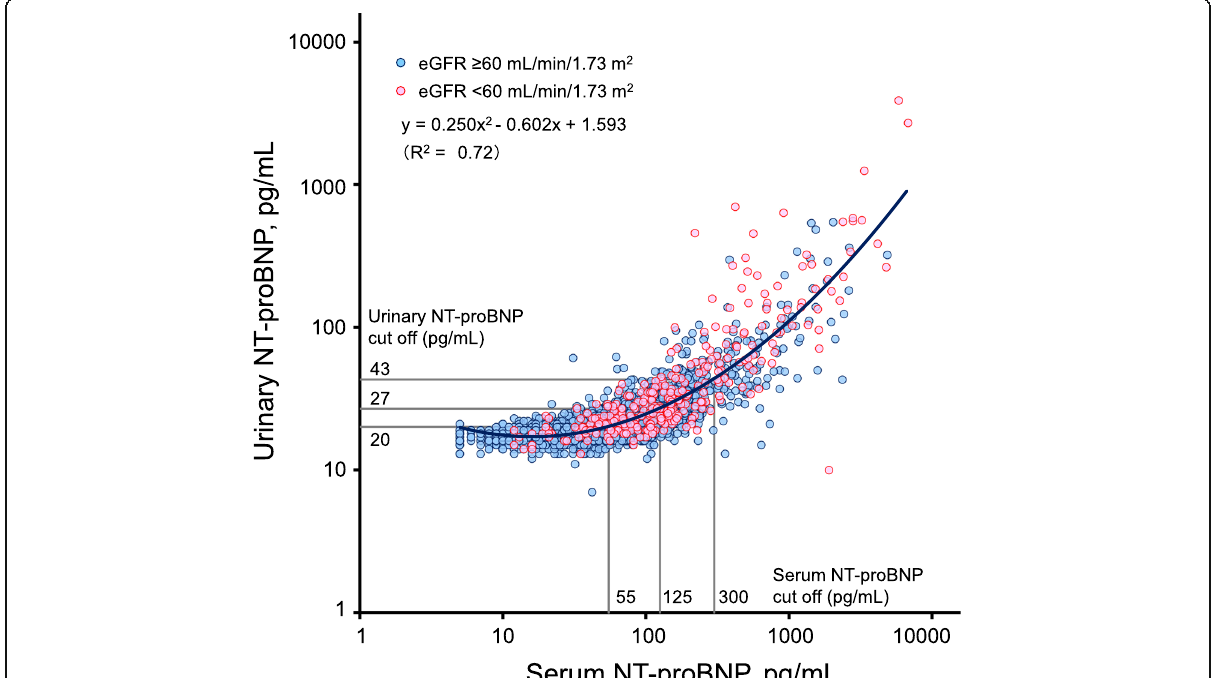
Fig. 1 Correlation between serum and urinary concentrations of NT-proBNP. Abbreviations: NT-proBNP , N-terminal pro – B-type natriuretic peptide; eGFR , estimated glomerular filtration rate. The horizontal axis (serum NT-proBNP) and the vertical axis (urinary NT-proBNP) are log scaled because of their skewed distributions. In the quadratic equation, x and y indicate the log-transformed (log 10 ) concentrations of serum and urinary NT- proBNP, respectively. The quadratic regression curve is shown in blue. Urinary NT-proBNP concentrations corresponding to the guideline-based cutoff values of serum NT-proBNP (55, 125, and 300 pg/mL) were 20, 27, and 43 pg/mL,